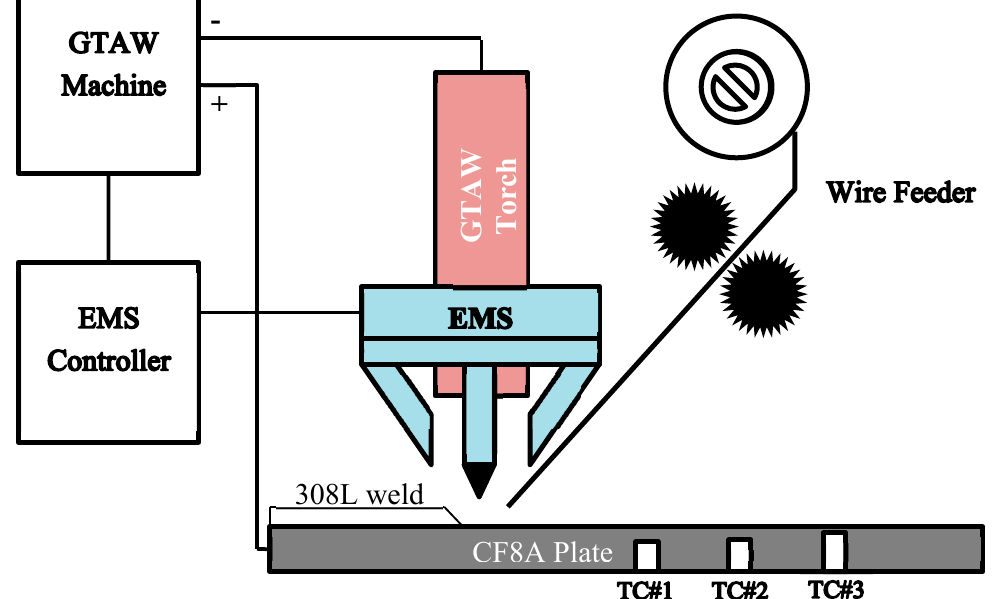
Figure 2. Schematic diagram of the experimental setup for the external electromagnetic stirring Figure 2 Schematic diagram of the experimental set-up for the external electromagnetic stirring 101 device. 102